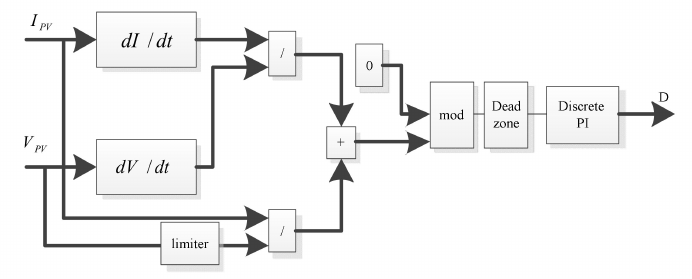
Figure 3. Incremental conductance (INC) method with the proportional-integral (PI) controlling